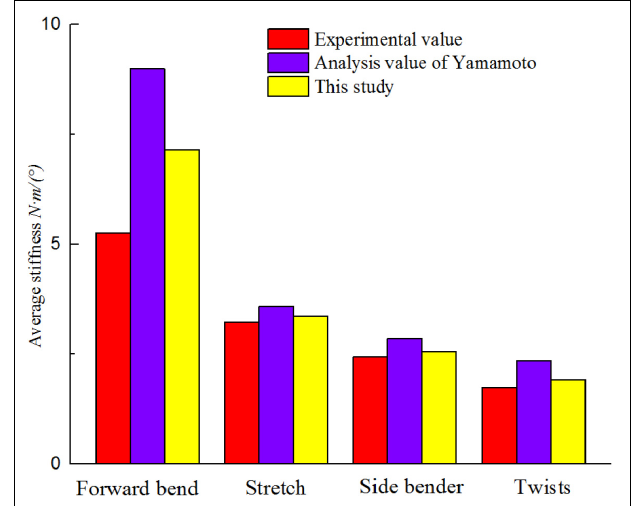
FIGURE 5 | Finite element model